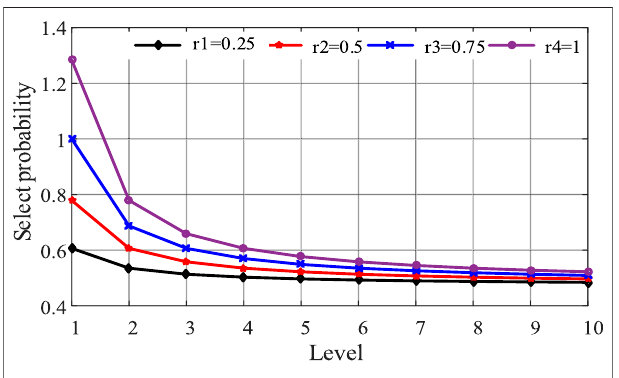
FIGURE 3 | Probability of individual selection at different.